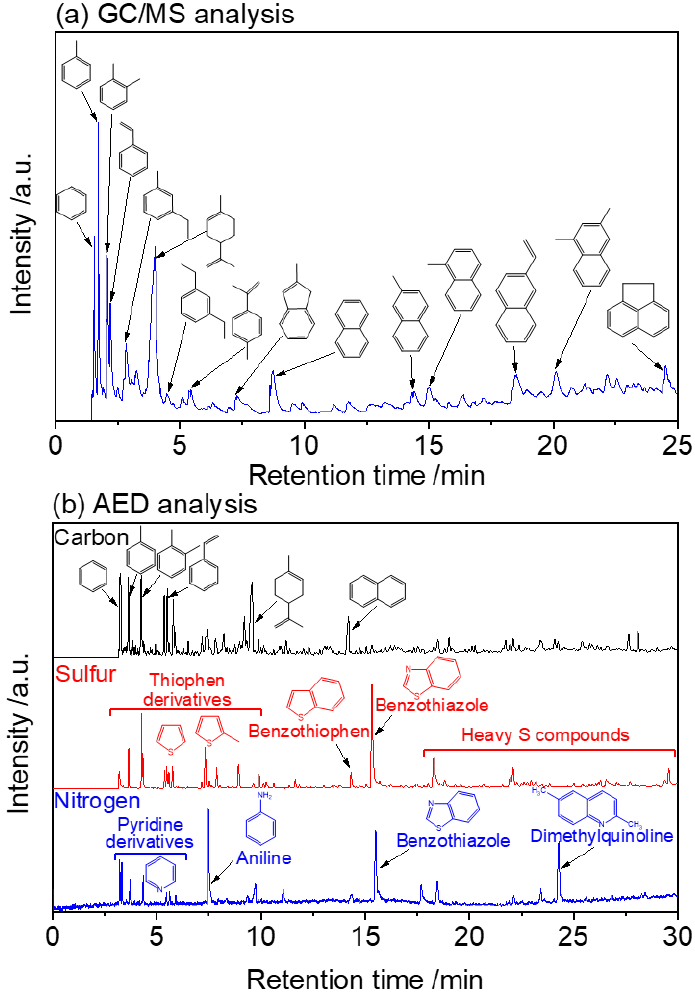
Figure 3. Characterization of tire pyrolysis oil by ( a ) GC/MS and ( b ) AED.